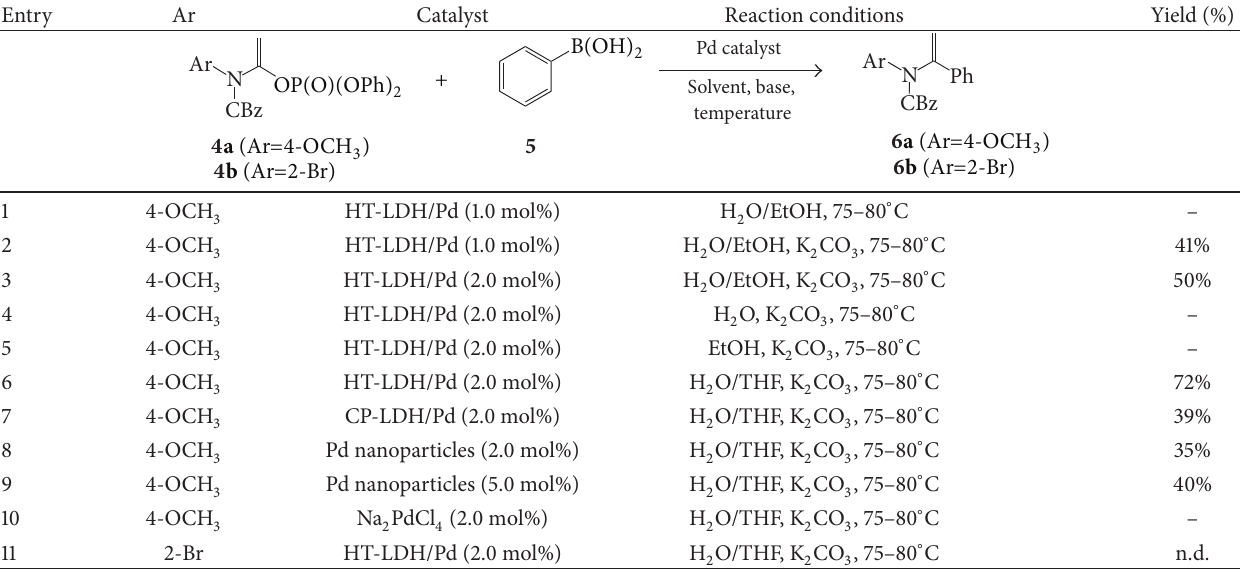
Table 1: Screening of the reaction conditions for the synthesis of the 𝛼 -phenyl-enecarbamates from the N -CBz protected enol phosphates. Entry